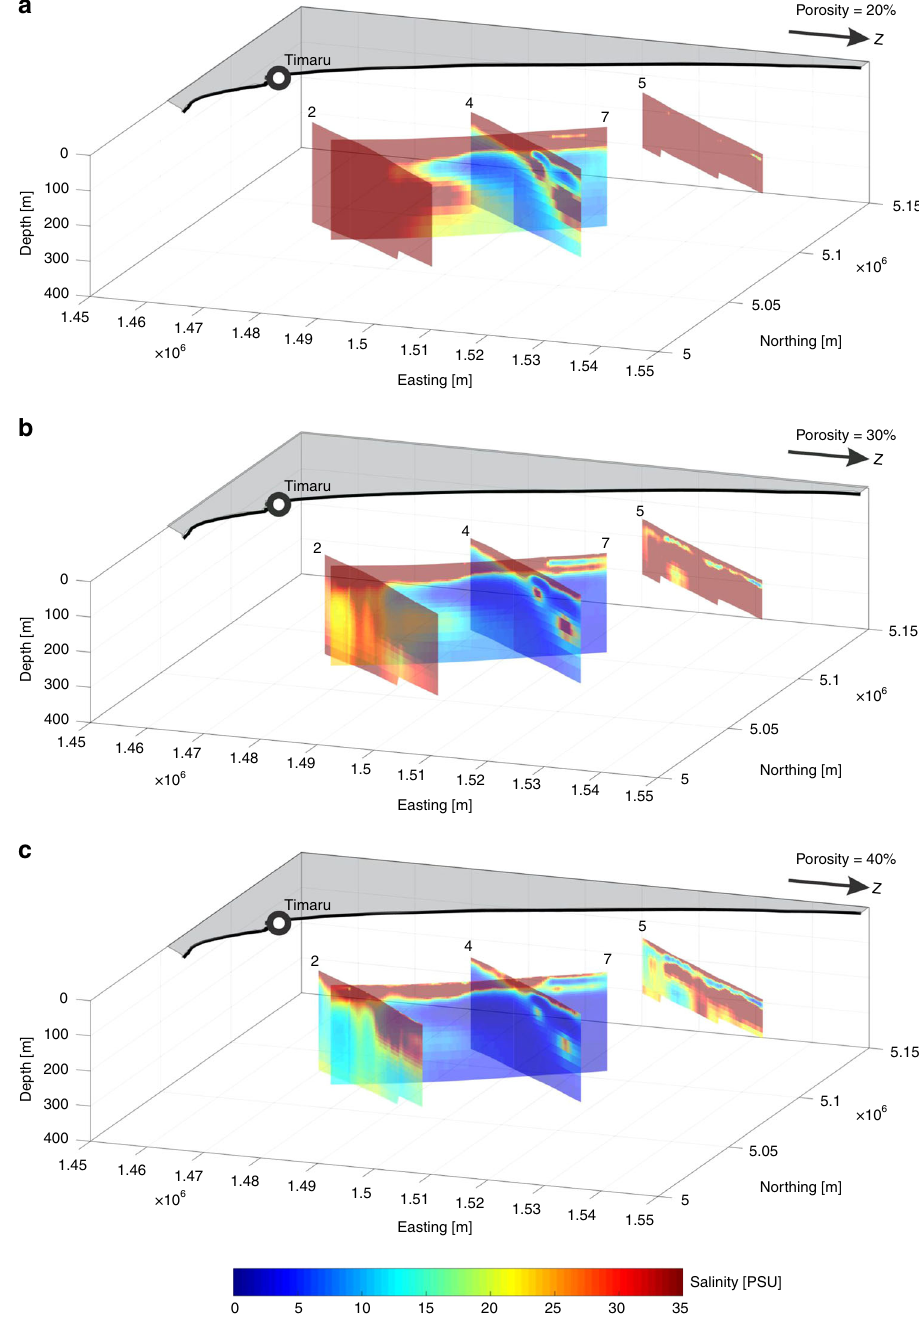
Fig. 6 Models of estimated sub-sea fl oor pore water salinity. Fence diagrams of salinity depth pro fi les derived from the resistivity models in Fig. 4 by applying Archie ’ s Law 45 and the Fofonoff and Millard algorithm 47 . We used constant porosities of a 20%, b 30% and c